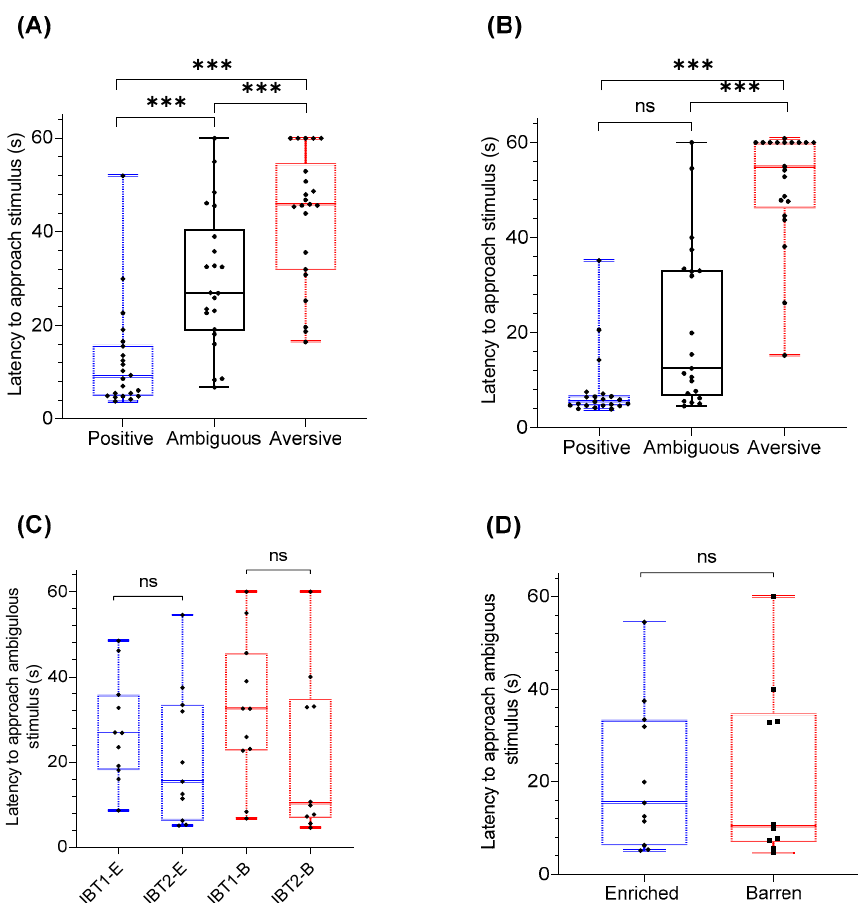
Figure 9. ( A ) Latency for pigs ( n = 23) to approach positive, aversive and ambiguous stimulus at judgment bias test 1 (JBT1), ( B ) latency to approach positive, aversive and ambiguous stimulus in judgment bias test 2 (JBT2) in pigs exposed to enriched housing ( n = 12), or barren housing ( n = 11), ( C ) indicates latency to approach ambiguous stimulus between JBT1 and JBT2 in pigs exposed to enriched ( n = 12), or barren housing ( n = 11), and ( D ) indicates latency to approach ambiguous stimulus during JBT2 in pigs exposed to enriched ( n = 12) or barren housing ( n = 11). Data are medians with range. Significant difference is indicated with presence of asterisk ( p < 0.05).